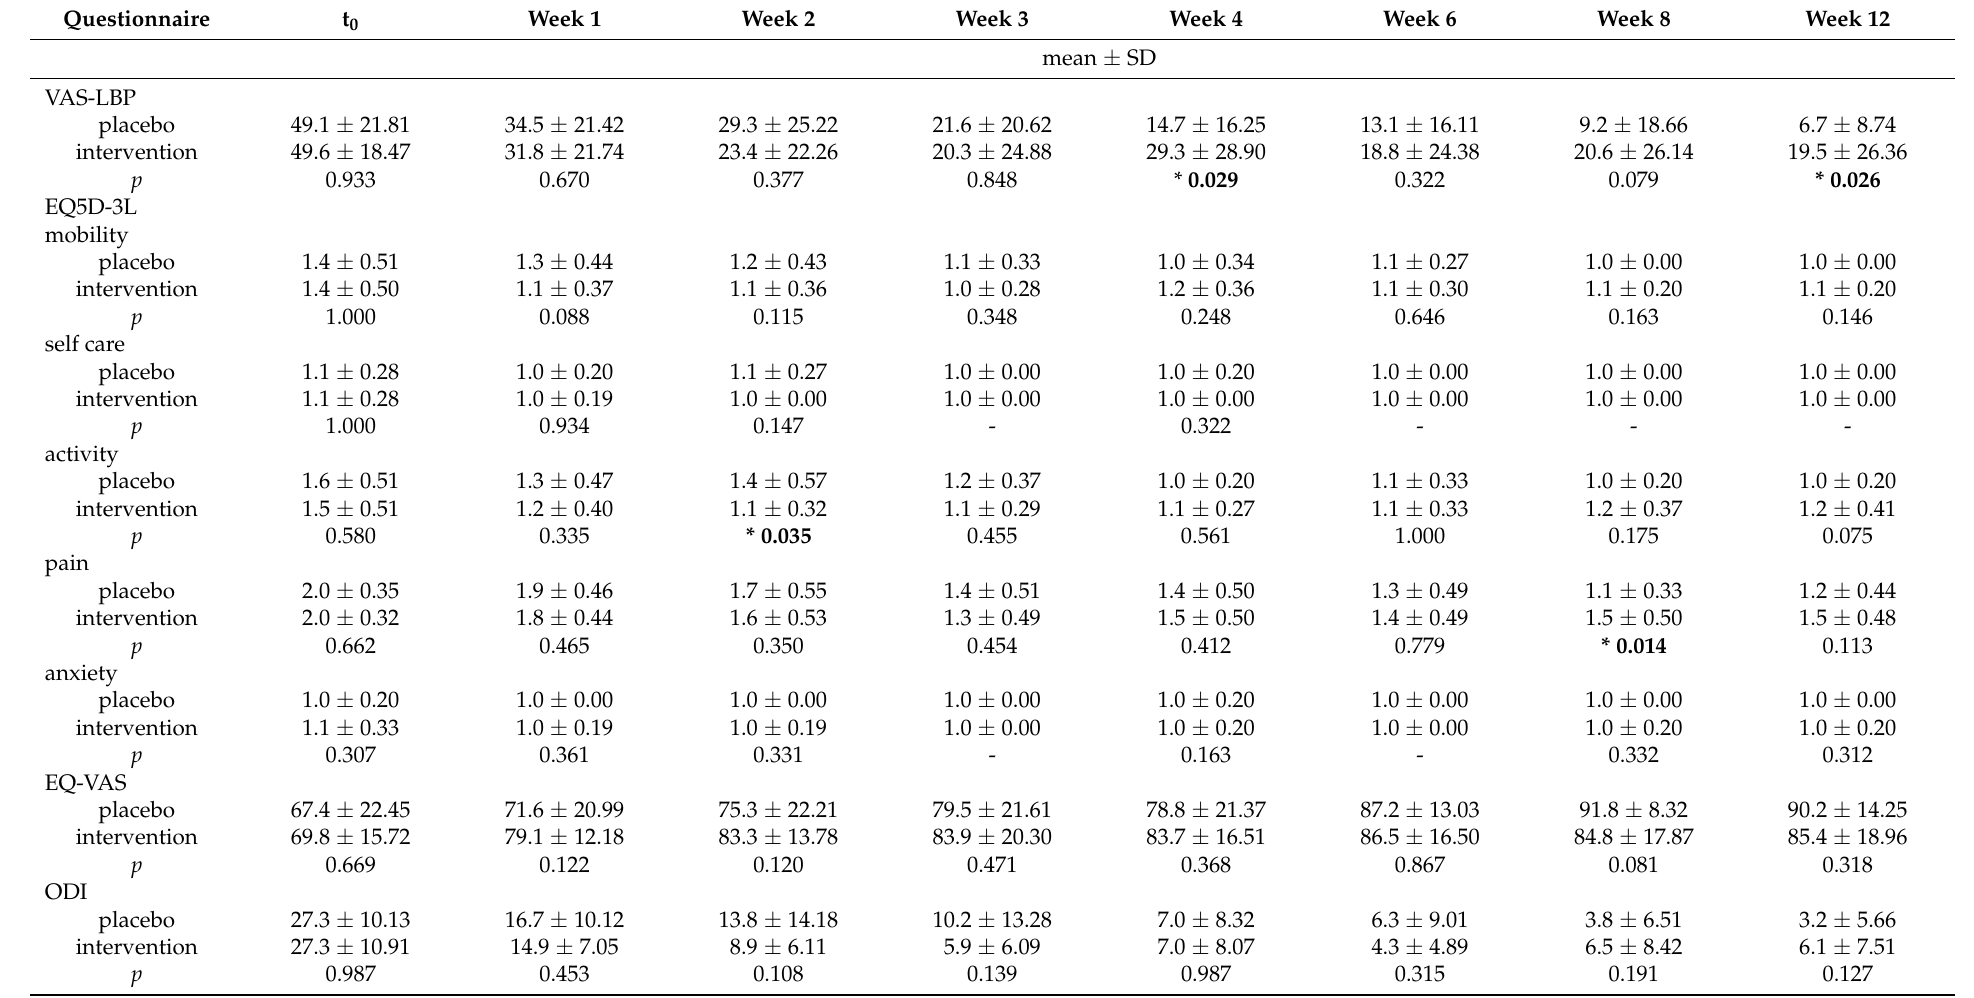
Table 1. Results for VAS-LBP, EQ-5D-3L, ODI, RDQ and